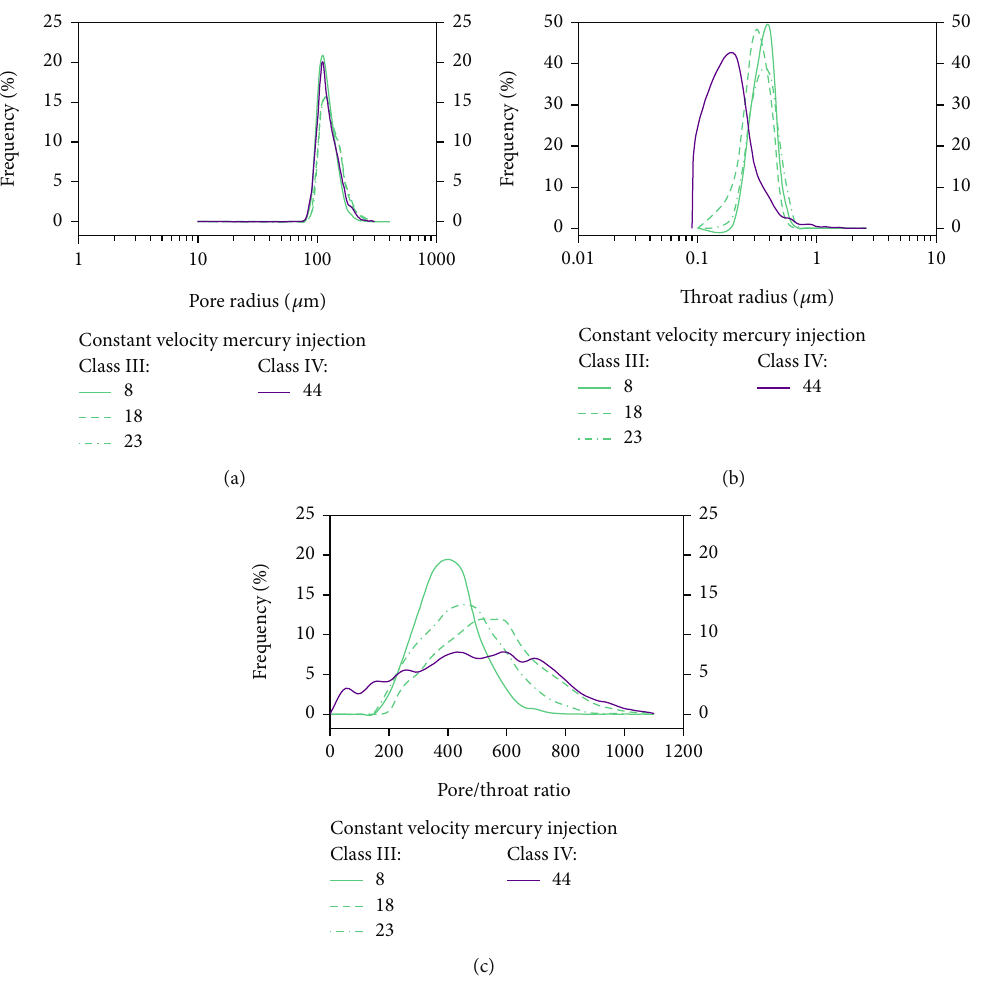
Figure 6: Distribution frequency curve of pore radius, throat radius, and pore throat ratio in constant velocity mercury penetration test of C 7 reservoir.